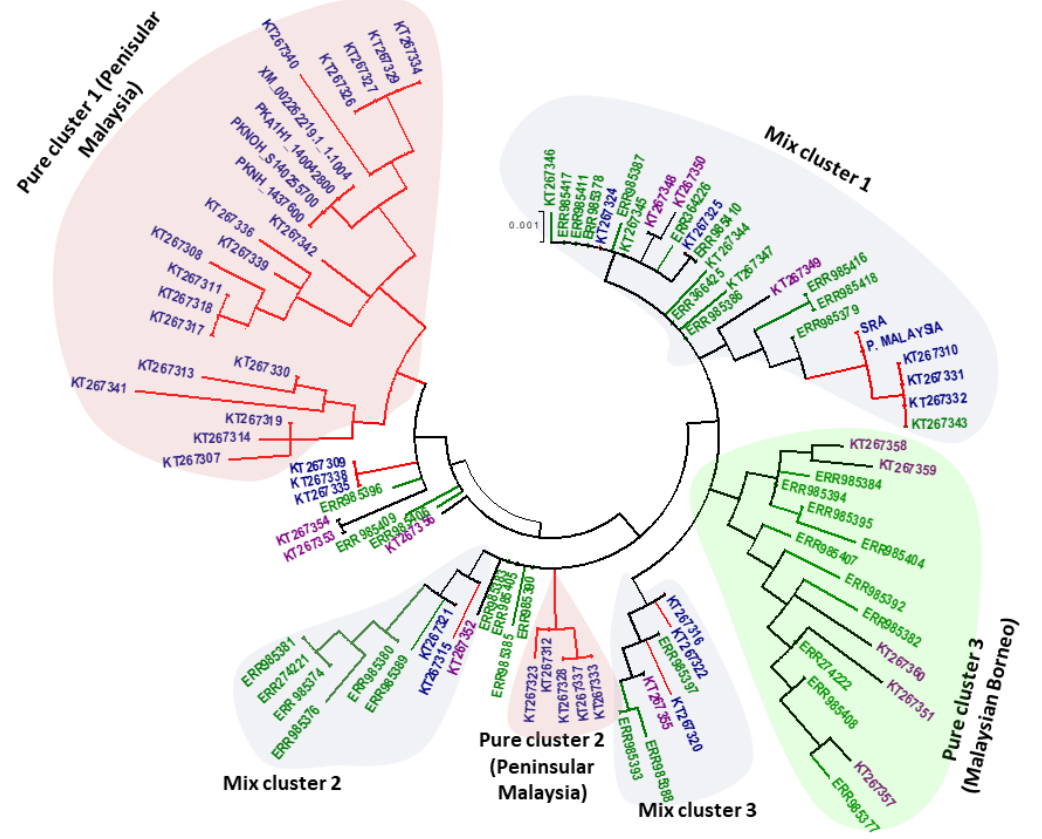
Figure 5. Phylogenetic tree comprising 97 nucleotide sequences of the PkTRAMP gene generated by MEGA 5.0 using the Maximum Likelihood method. The constructed tree shows clustering of the PkTRAMP gene from different regions and is labeled as pure clusters 1 & 2, which contain samples from Peninsular Malaysia (light pink), pure cluster 3, which contains samples from Malaysian Borneo (light green), and mixed clusters 1, 2 and 3, which contain samples from both Malaysian Borneo and Peninsular Malaysia (light grey).